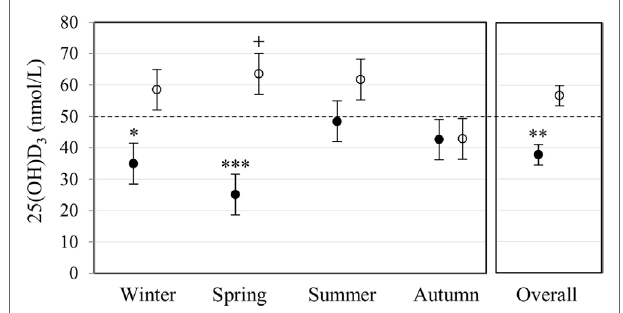
FigUre 1 | Race and season influenced plasma 25(OH)D 3 concentration. The error bar plot shows the mean plasma 25(OH)D 3 concentration, quantified by liquid chromatography tandem mass spectrometry, for healthy Black (filled markers, n = 50) and White (open markers, n = 53) South Africans, collected in winter (Black n = 17, White n = 10), spring (Black n = 10, White n = 16), summer (Black n = 10, White n = 11), and autumn (Black n = 13, White n = 16). Blacks were deficient ( < 50 nmol/L), having a significantly lower plasma 25(OH)D 3 concentration than Whites in winter (* P < 0.050), spring (*** P < 0.001), and overall (** P < 0.010). Overall, whites had normal 25(OH)D 3 levels ( ≥ 50 nmol/L, ≤ 125 nmol/L), with a significantly higher plasma 25(OH)D 3 concentration in spring compared to autumn ( + P < 0.050). P -Values were adjusted using Bonferroni correction. Error bars show the unadjusted least significant difference at P < 0.050. The dotted line indicates the border between normal and